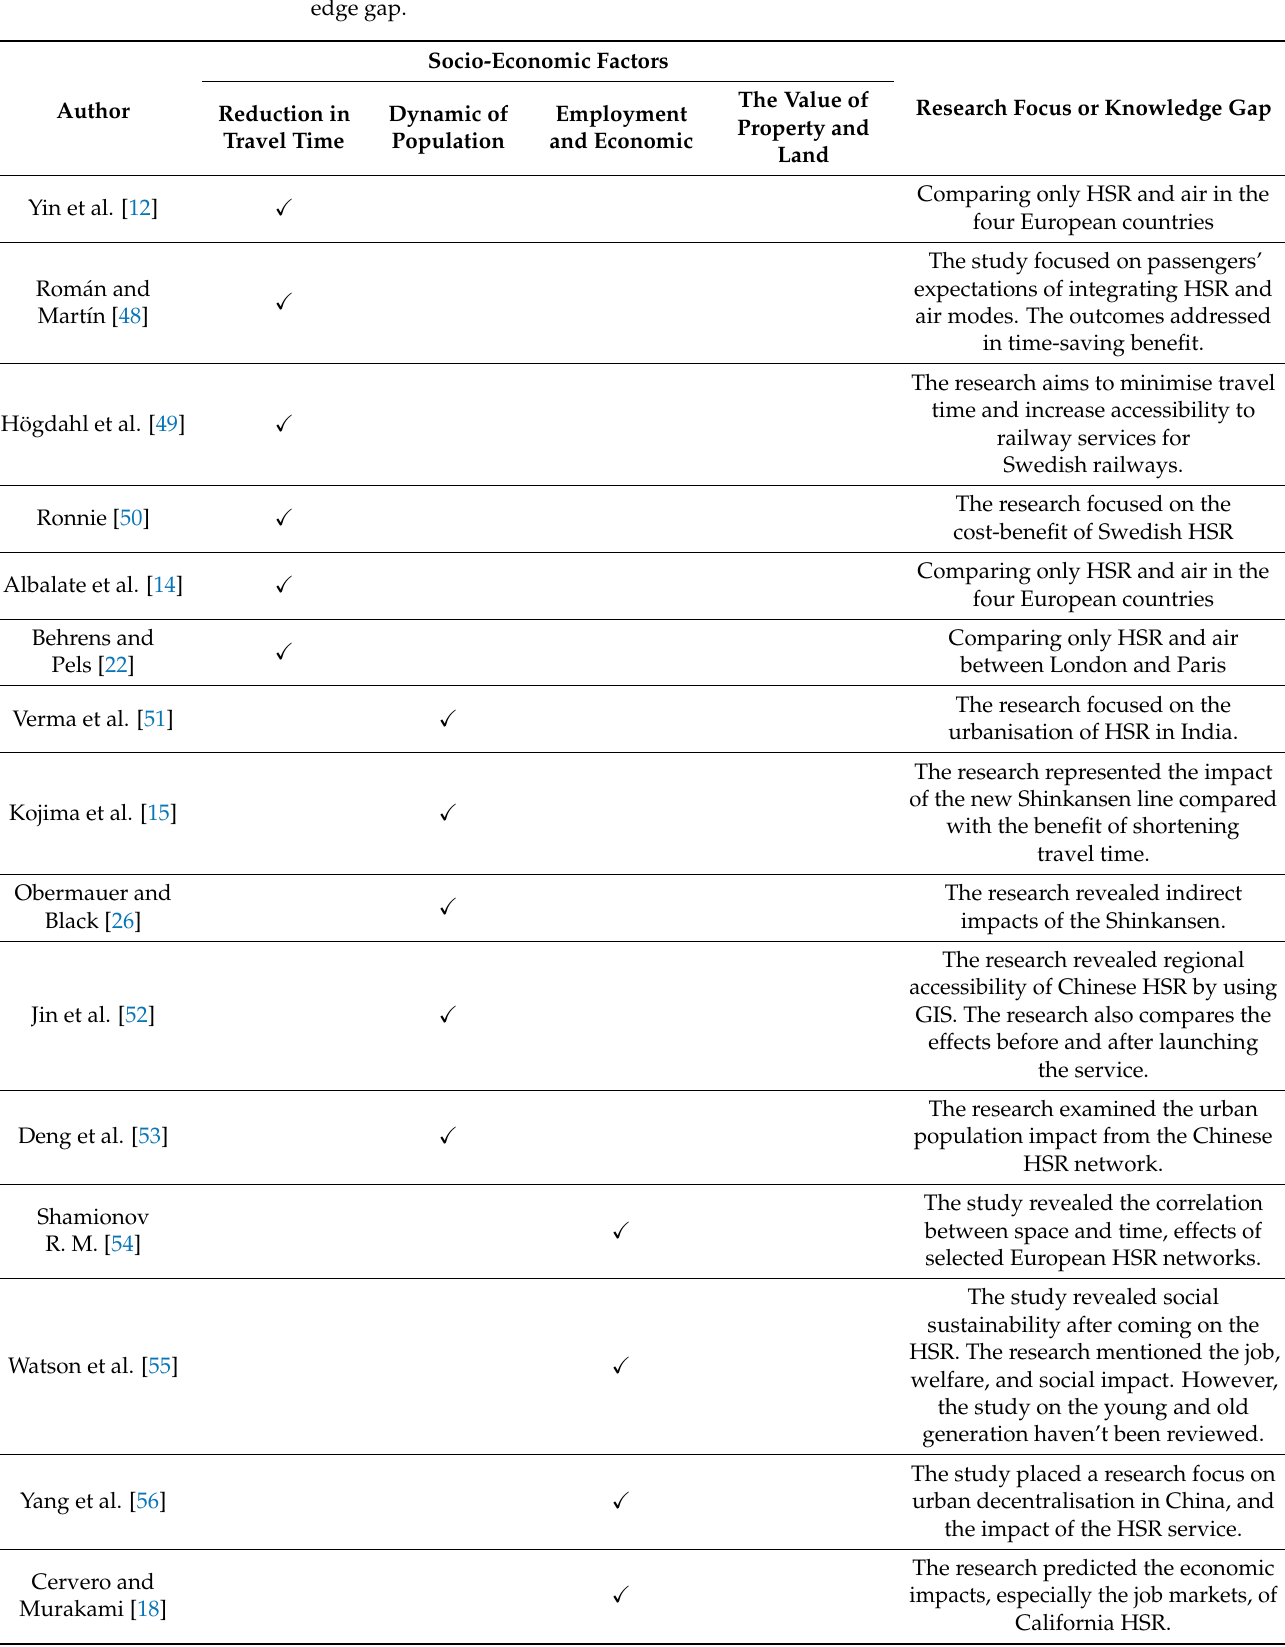
Table 1. An overview of prior studies’ research goals regarding socio-economic factors and knowl- edge